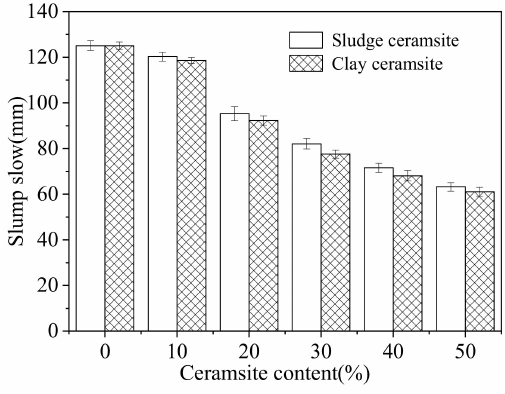
Figure 5. Slump flow of ceramsite cement